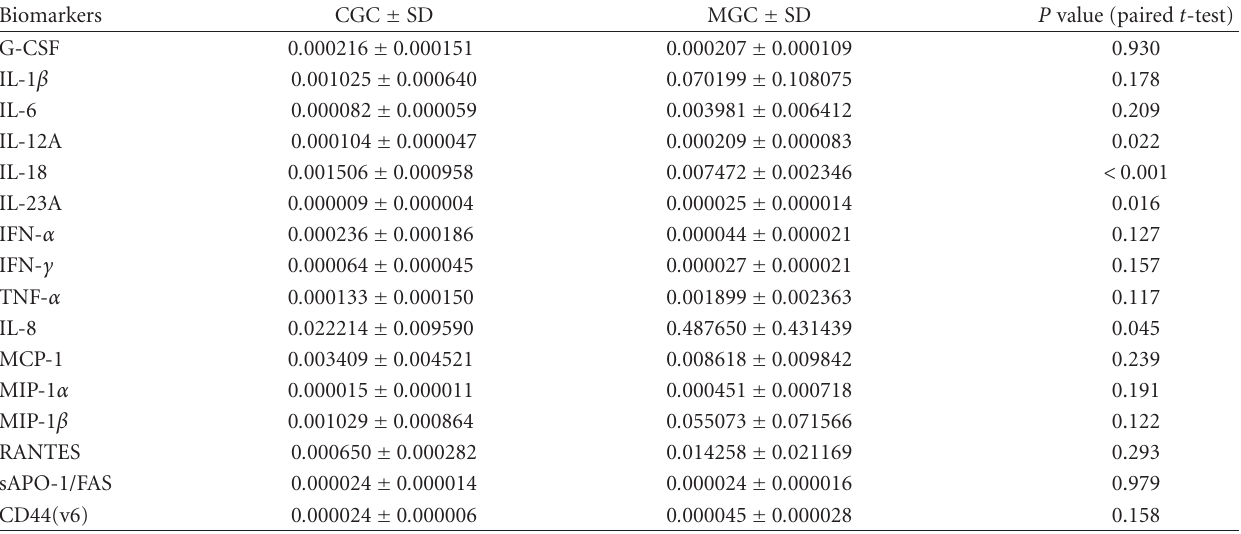
Table 4: Relative ∗ mRNA abundance of measured proteins in cumulus and mural granulosa cells.